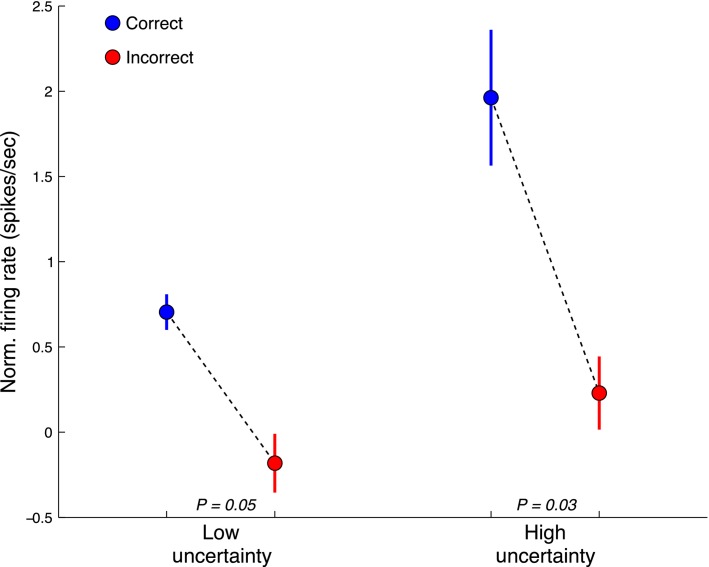
SN dopamine neuronal firing rate correlates with outcome under conditions of both high and low uncertainty. Normalized SN dopaminergic neuronal firing rate is higher for correct decisions under conditions of both high (P < 0.03, unpaired t-test) and low uncertainty (P < 0.05). When accounting for both outcome and uncertainty using a 2-way ANOVA, outcome remained the only significant effect on firing rate (F = 8.39, P = 0.0039). While the difference in firing rate was increased under highly uncertain conditions (1.73 spikes/sec) relative to low uncertainty (0.89 spikes/sec), this effect (interaction) was not statistically significant although the effect size on outcome was larger when including uncertainty (F = 8.39, P = 0.0039 vs. F = 4.67, P = 0.03, respectively).